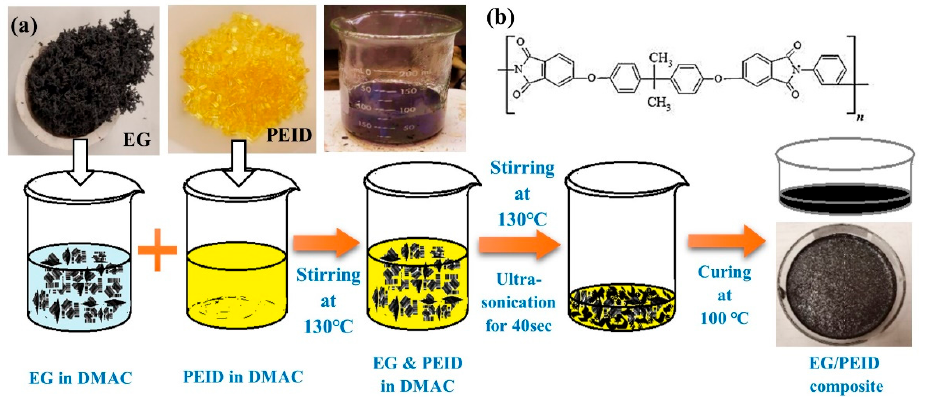
Figure 2. ( a ) Schematic for the preparation process of EG/PEID composites, ( b ) chemical structure of PEID.